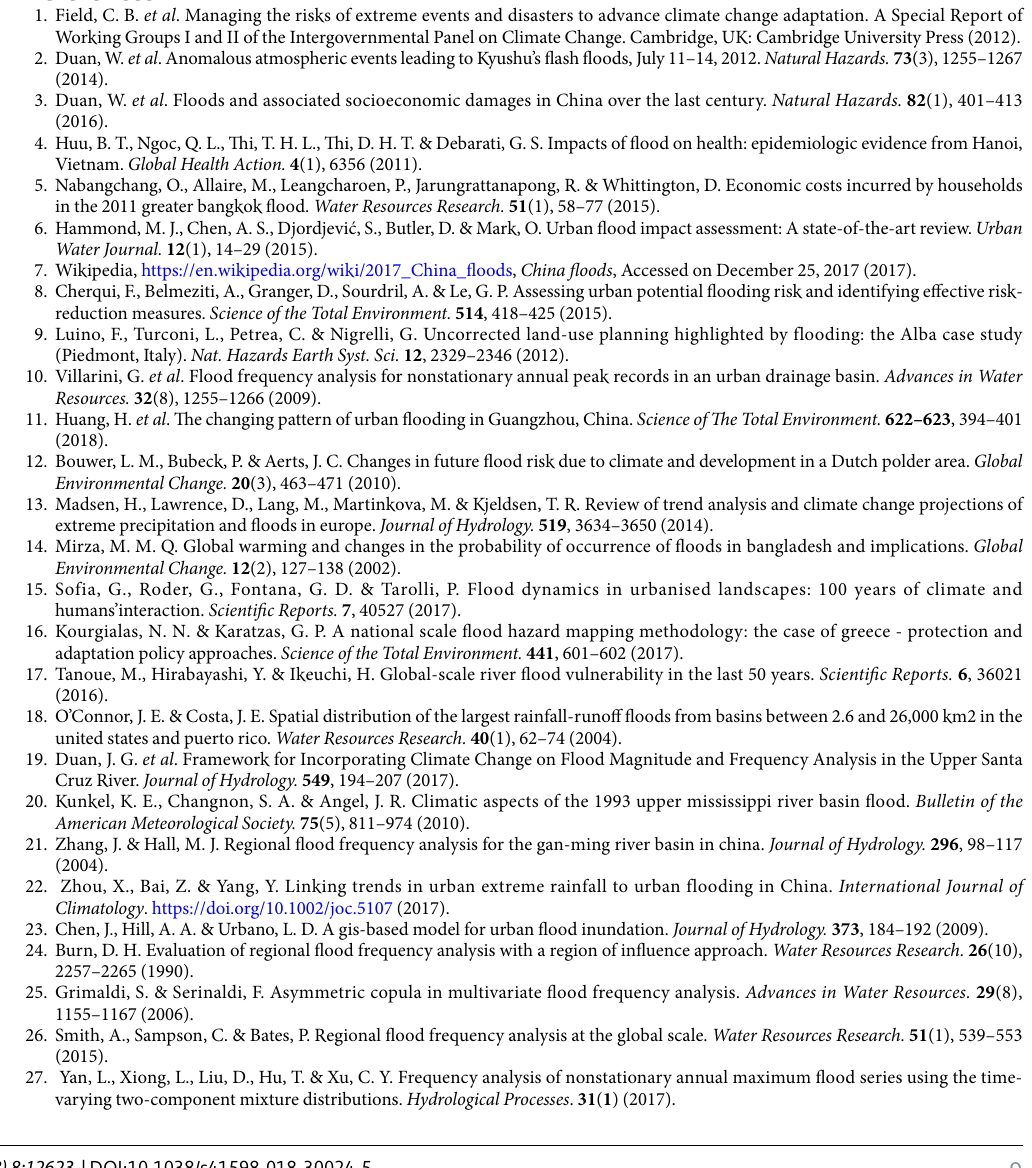
which were explained in Section 4.2. Observed data for model calibration was based on referenced photos taken during the 2008 flood events. We judged the referenced water depth for comparison to the simulated water depth. (2) Model application. Elevation input data and hydrological parameters were assigned for each grid cell. different rainfall scenarios. The pump station location and capacity were input to the model. (3) Result comparison. Simulated water depth of 2008 historical flood event was compared with the